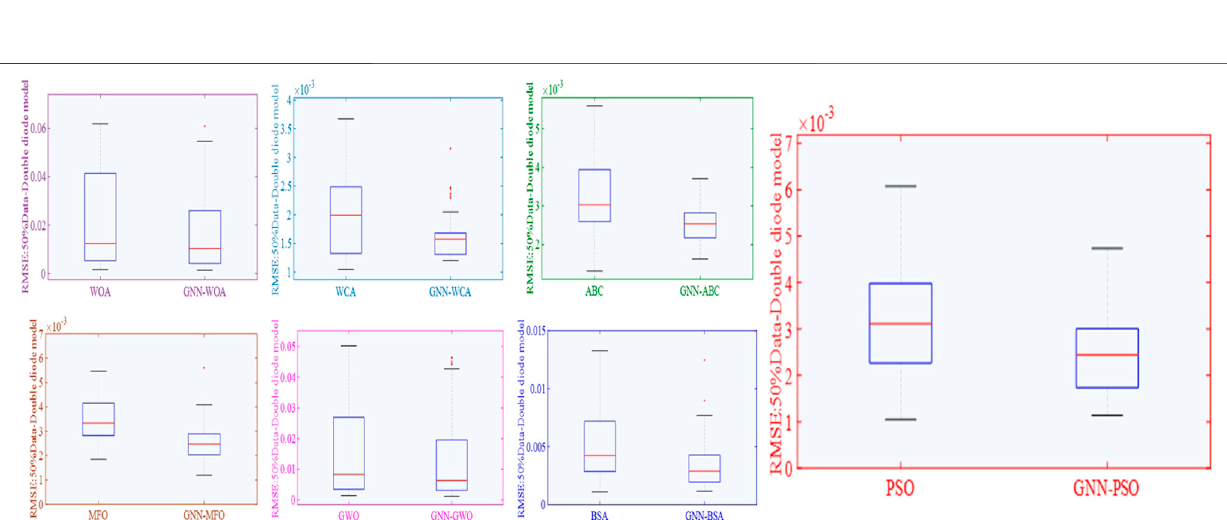
FIGURE 9 | Convergence of various algorithms for the DDM. (A) With the GNN under 50% data; (B) without the GNN under 50% data; (A) with the GNN under 100% data; (B) without the GNN under 100% data.